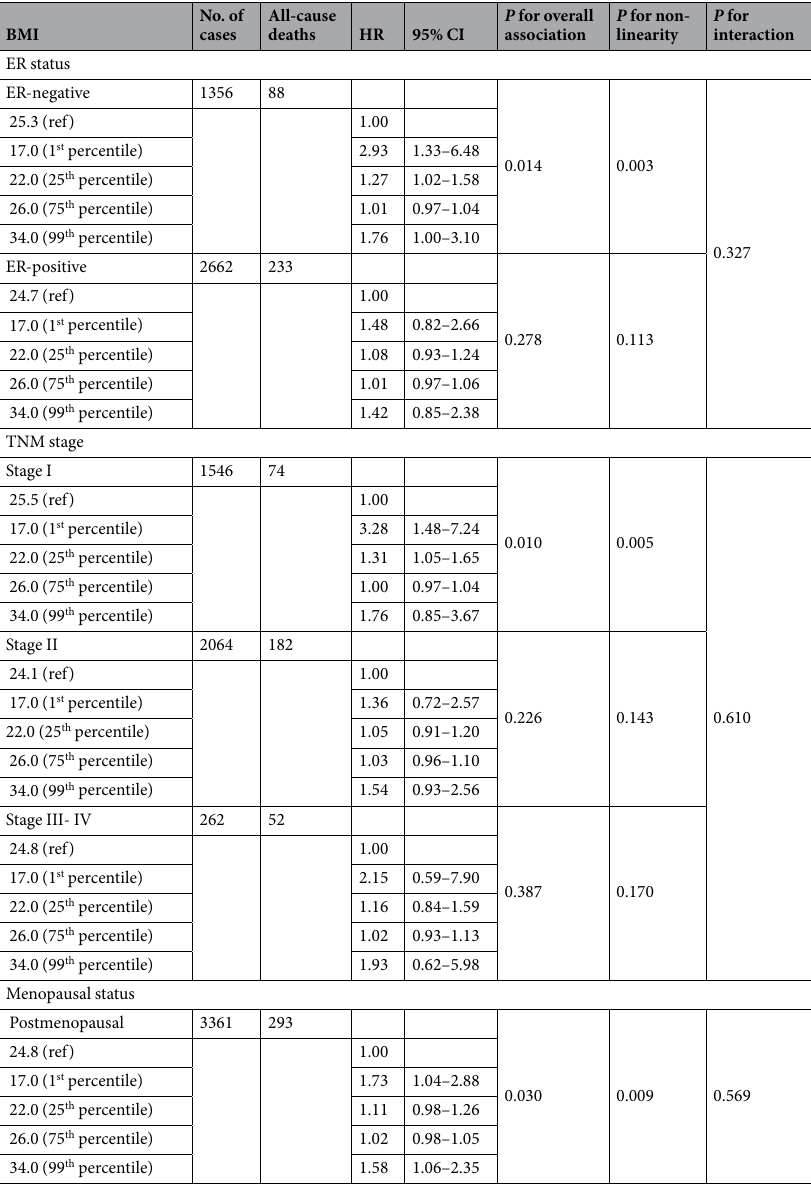
Table 4. Hazard ratios and 95% confidence intervals for post-diagnosis BMI in association with late all-cause mortality by ER status and menopausal status, the Shanghai Breast Cancer Survival